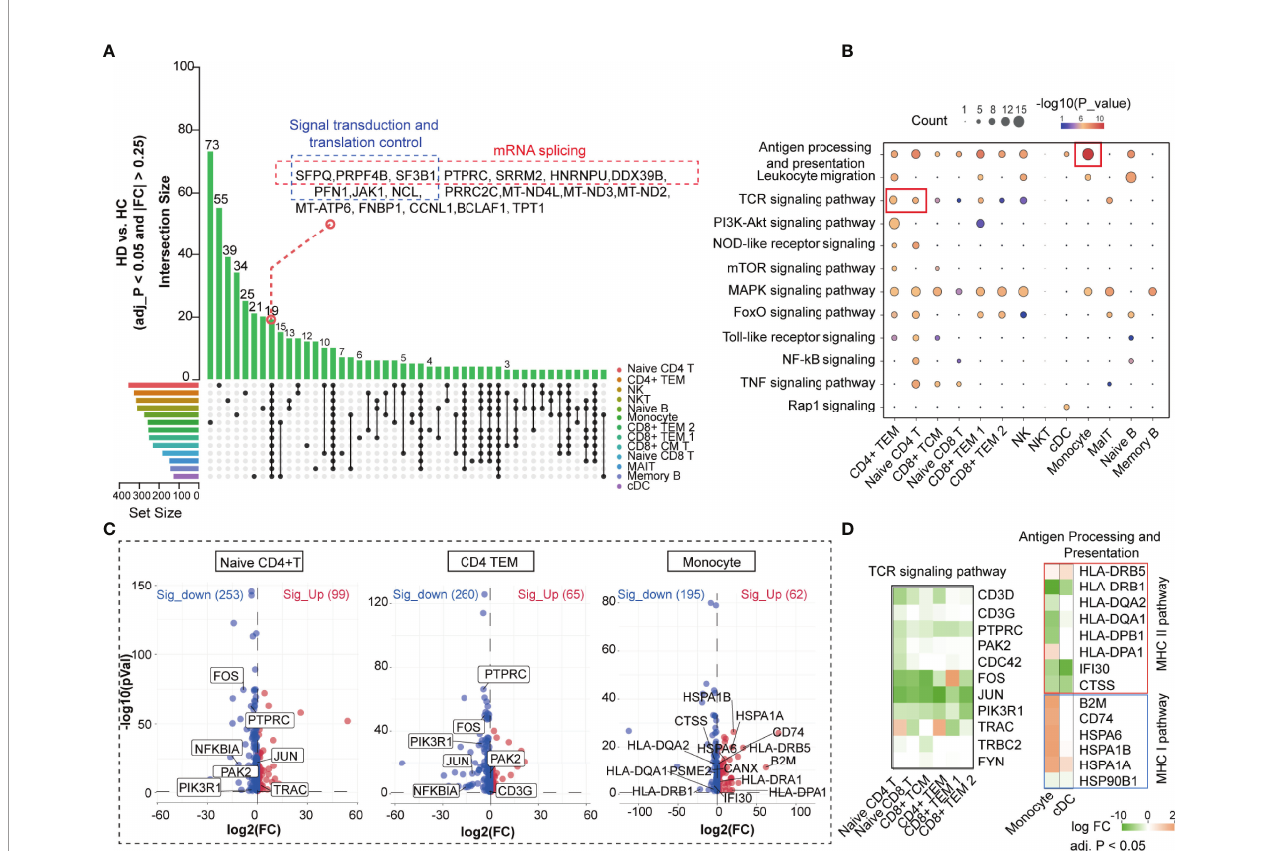
FIGURE 3 | Hemodialysis-related changes in the biological process of PBMC subpopulations based on the scRNA-seq data. (A) UpSet plot showing the integrated comparative analysis of DEGs in PBMC subpopulations between HD and HC groups. The horizontal bars on the left show the number of the DEGs for each PBMC subpopulation. Each color represents one PBMC cluster. Individual dots indicate the DEG set speci fi c to a cell subset. The lines between dots indicate the shared DEG set between PBMC subpopulations. The vertical bars indicate the number of DEGs in the corresponding DEG set. (B) KEGG analysis of DEGs in PBMC subpopulations. The dot size denotes the number of DEGs in the corresponding pathway. Color bars show P values. KEGG analysis is performed by DAVID. (C) Volcano plot showing DEGs in CD4+ TEM, naive CD4+ T cells, and monocytes. (D) Heatmap showing expression levels of the key DEGs in the corresponding PBMC subpopulations. The color bar shows FC values. PBMC, peripheral blood mononuclear cell; DEGs, differentially expressed genes; KEGG, Kyoto encyclopedia of genes and genomes; DAVID, database for annotation, visualization and integrated discovery; FC, fold